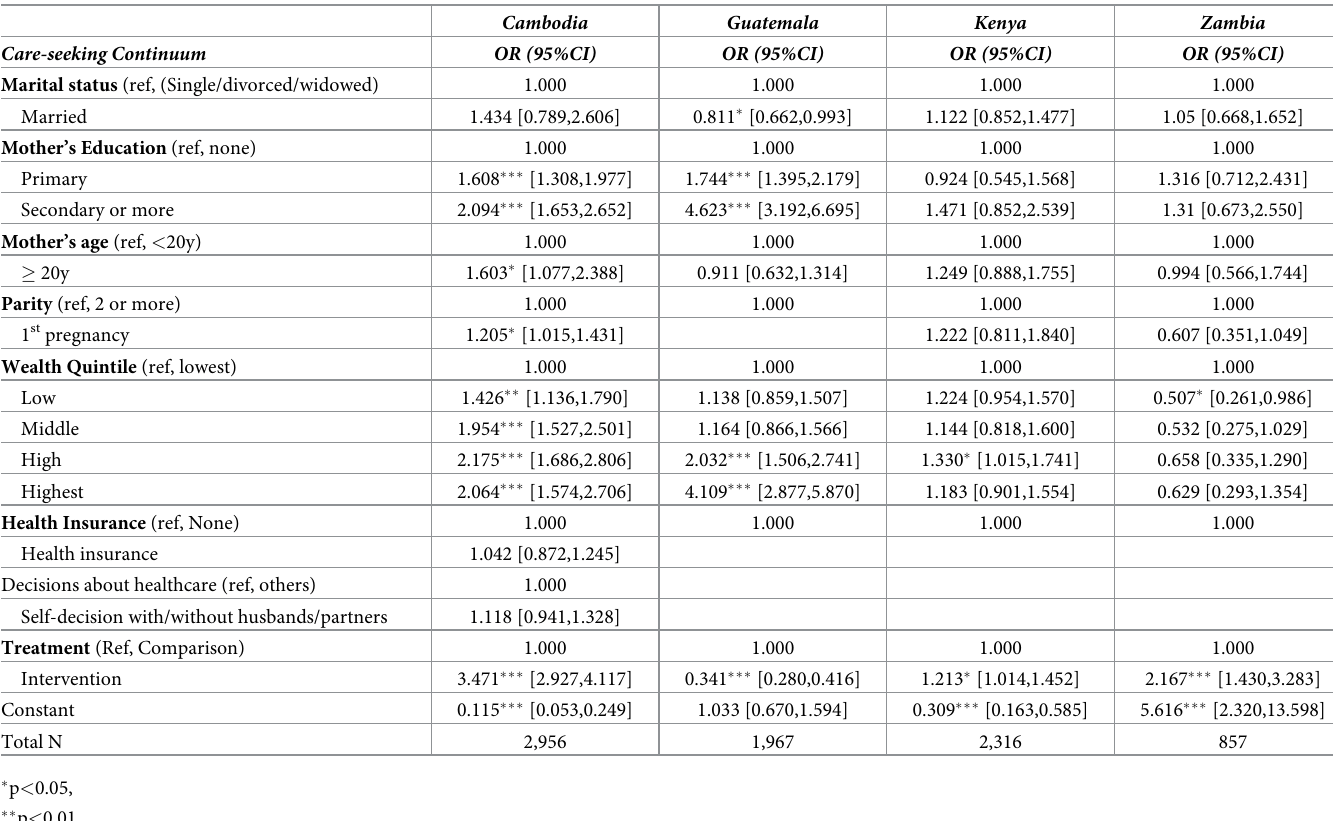
Table 5. Multivariate logistic regression of factors associated with care continuum